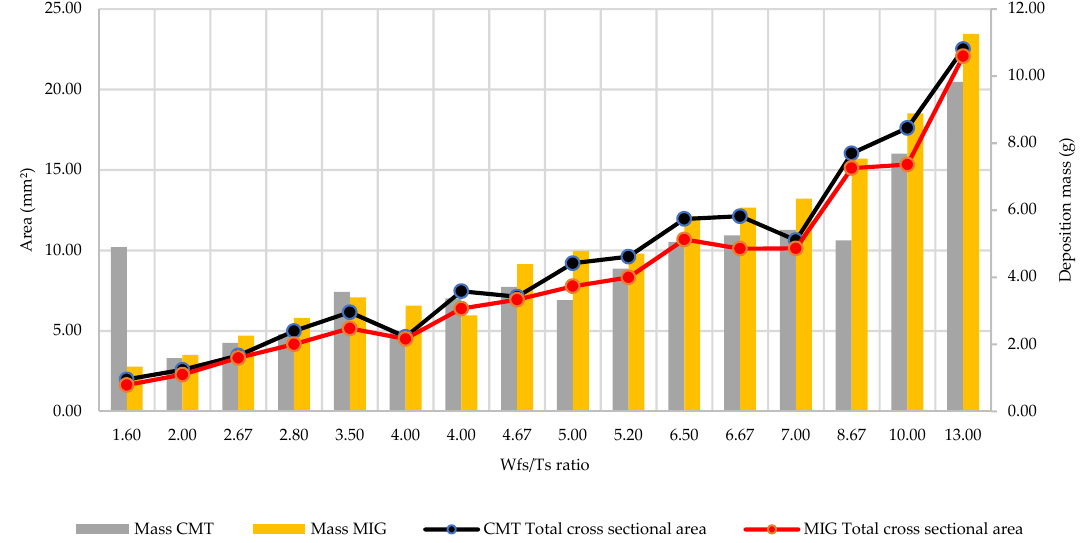
Figure 14. Combined data for deposit mass and total cross-sectional area plotted against each Wfs/Ts datapoint.